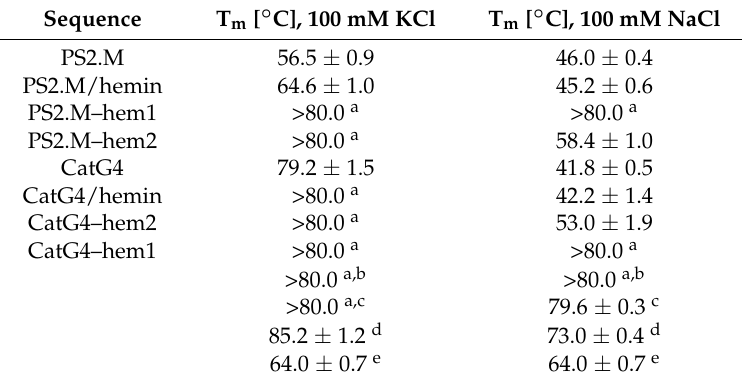
Table 2. Melting temperatures (T m ) for DNA oligonucleotides and conjugates following circular dichroism (CD) spectroscopy at 260 nm. The values were averaged across three experiments. Sequence T m [ ◦ C], 100 mM KCl T m [ ◦ C], 100 mM NaCl PS2.M 56.5 ±